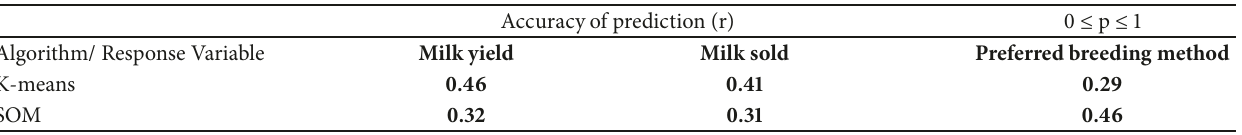
Accuracy of prediction (r) 0 ≤ p ≤ 1